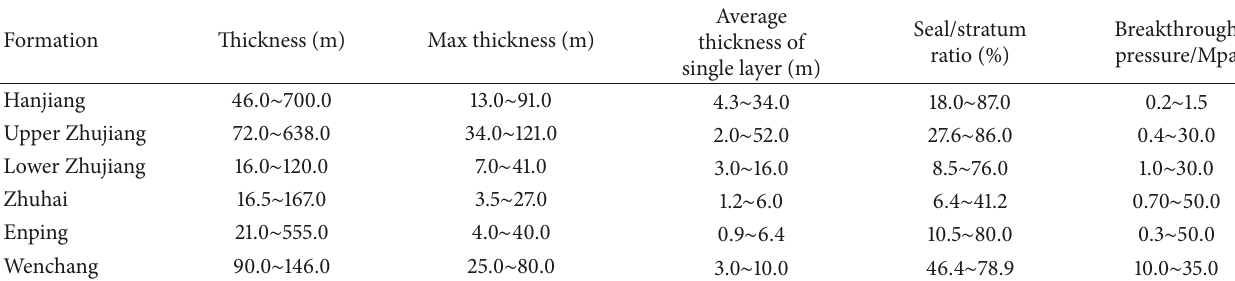
Table 3: Parameters of mudstone seal in the Huizhou Sag